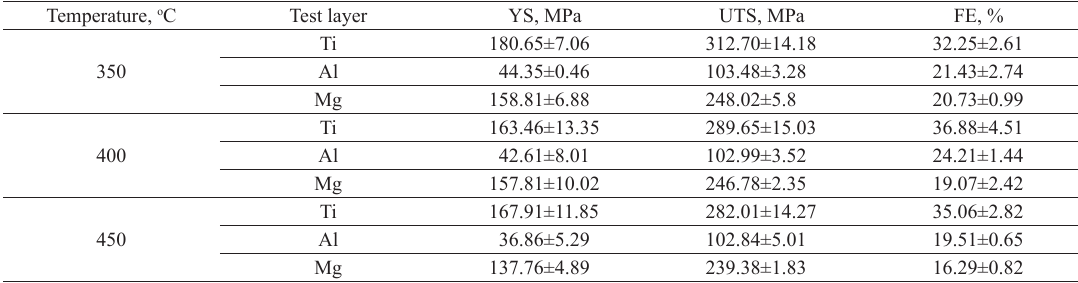
Table 3. Comparison of the theoretical values and the measured values of YS and UTS in LMCs at different hot-pressing temperatures. Temperature, o